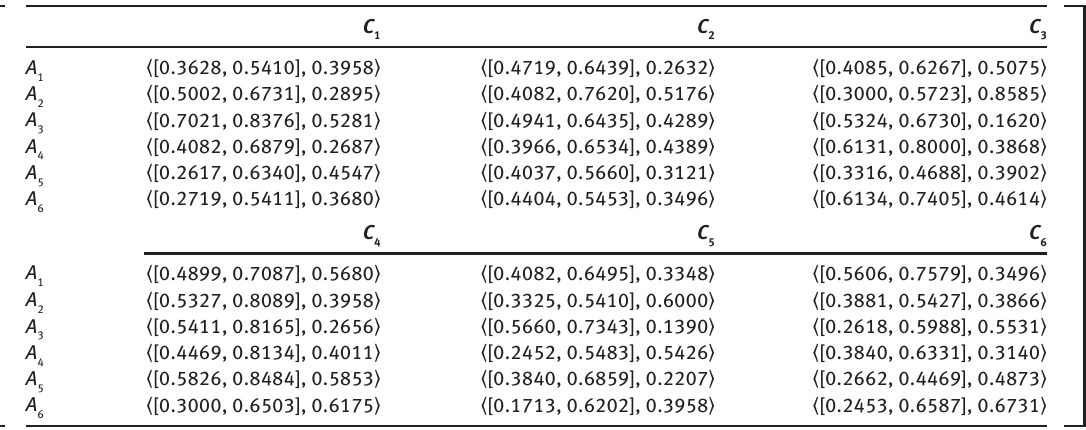
Table 6: Collective Result.